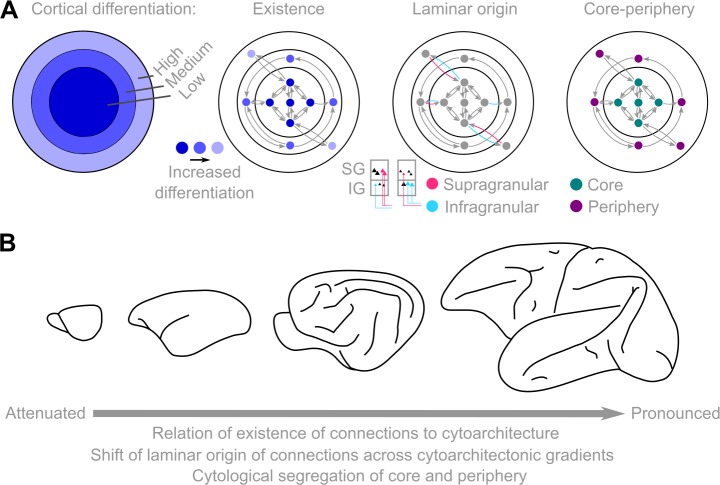
Unifying principles of mammalian connectomes and their common and diverse manifestation across species.(A) Cytoarchitectonic gradients of the cerebral cortex and their relation to fundamental interareal connectome features (existence and laminar origin of connections) and global network topology (core–periphery). (B) The relation of cytoarchitecture and connectome features is manifested in a species-specific manner, distinguishing the mouse and the marmoset monkey from the cat and macaque monkey. The direction of the arrow denotes pronounced correspondence of cytoarchitectonic similarity and existence of connections, pronounced shifts of the laminar origin of connections across the cortical sheet, and neuronal sparsification of the structural core, resulting in the segregation of the cytology of core and periphery areas. IG, infragranular; SG, supragranular.